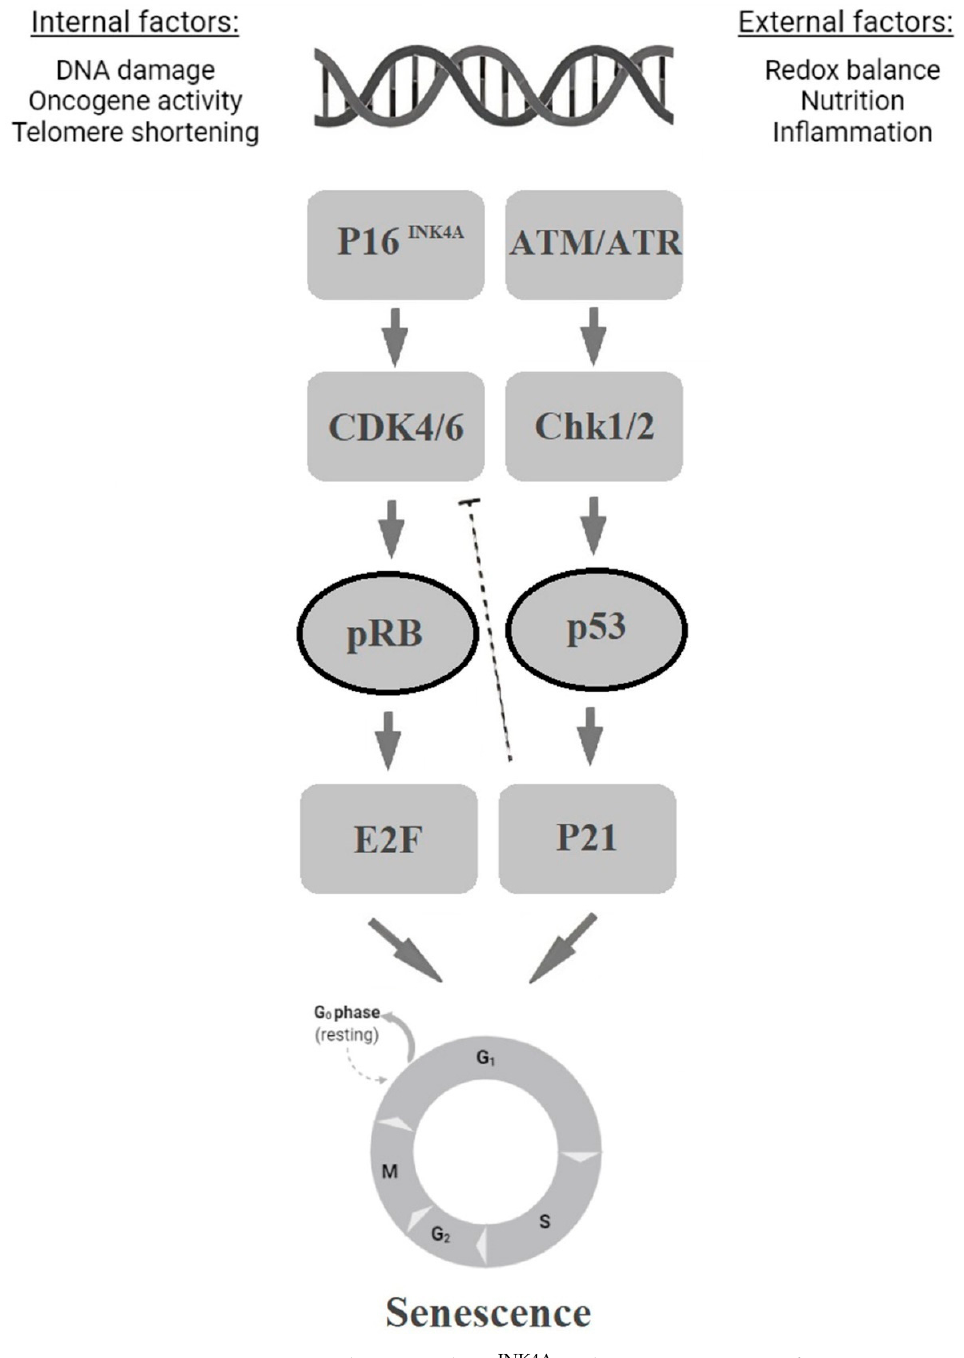
Figure 3. Senescence activation via the p53 and p16 INK4A pathways. Many stress factors can initiate senescence via the p16 and/or p53 pathways. Under specific circumstances, p16 inactivates CDK4/6, which leads to pRb accumulation and the regulation of the E2F transcription factors, resulting in senescence. DNA damage and DDR can also lead to ATM-Chk2 or ATR-Chk1 regulation with subsequent p53 and p21 activation